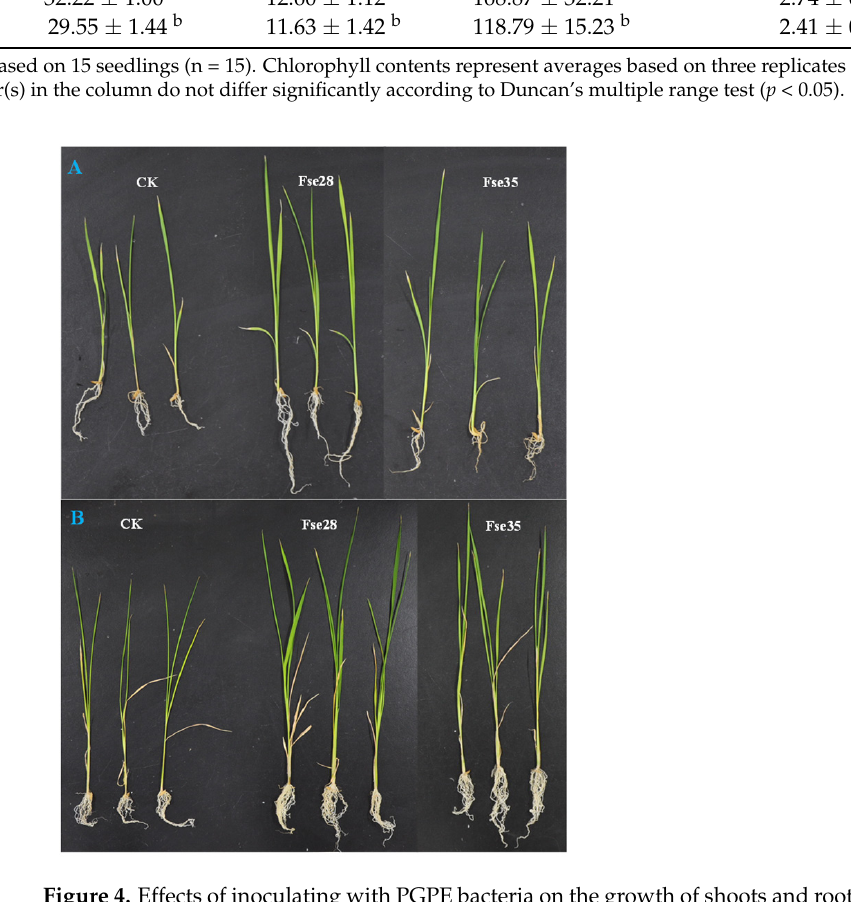
Data represent averages based on 15 seedlings (n = 15). Chlorophyll contents represent averages based on three replicates (n = 3). Mean values with the same letter(s) in the column do not differ significantly according to Duncan’s multiple range test ( p < 0.05).